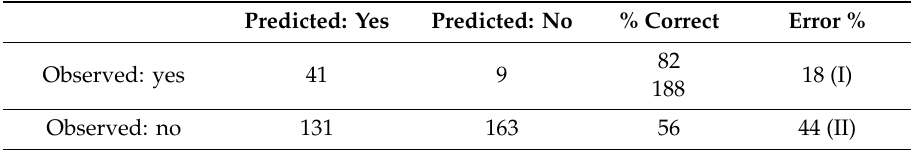
Table 4. Classification accuracy of the ADD model corresponding to a cut-o ff point of 0.63.